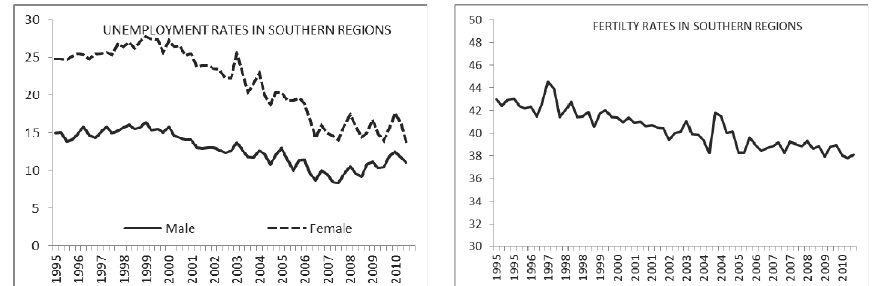
Figures 7, 8 – Unemployment and fertility rates in Southern